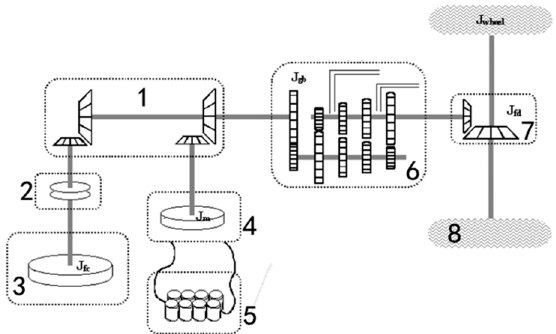
Figure 1. Parallel plug-in hybrid electric vehicle (PHEV) powertrain and transmission system (1— Touque Coupler; 2—Clutch; 3—Engine; 4—Motor; 5—Energy Storage System; 6—Gearbox; 7—Final Drive; 8—Wheels).